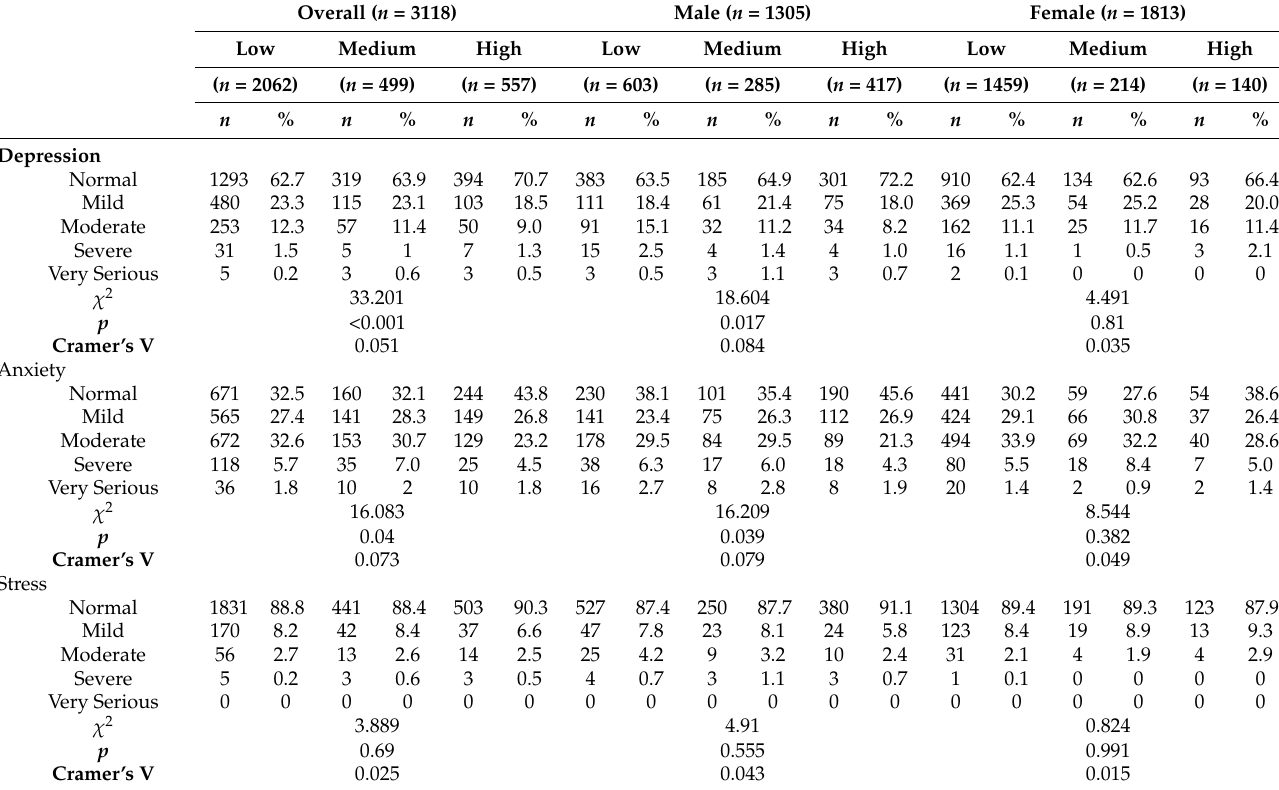
Table 2. Differences in negative emotions of college students for different physical-exercise